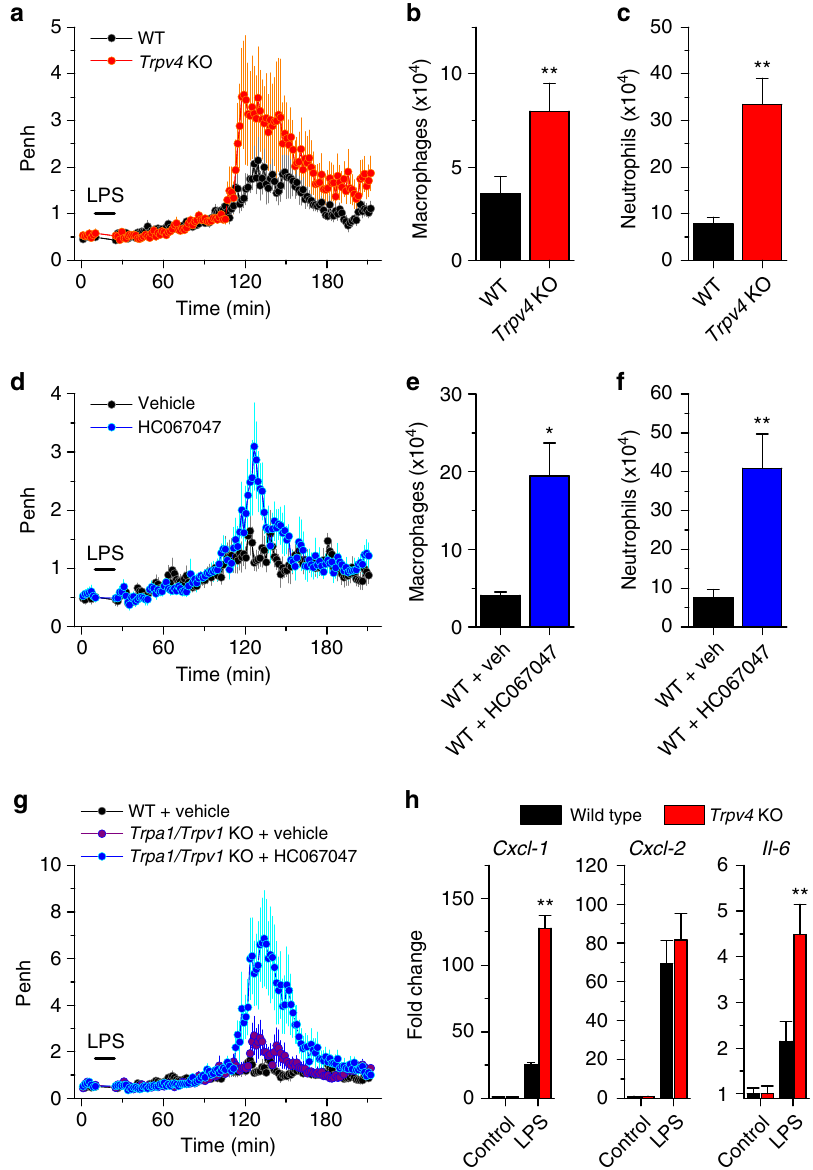
Fig. 7 TRPV4-de fi cient mice display exacerbated airway responses to LPS. a Time course of average enhanced pause (Penh) determined in unrestrained whole-body plethysmography experiments performed in wild type (WT, n = 10) and Trpv4 KO ( n = 7) mice exposed to aerosols of LPS. The area under the curve (AUC) of Trpv4 KO traces is signi fi cantly larger than AUC from WT (144 ± 56 > 47 ± 14; P = 0.048, unpaired t -test). b , c Average number of macrophages ( b ) and neutrophils ( c ) in the bronchoalveolar lavage fl uid collected 3 h after LPS exposure. ** P < 0.01, two-tailed t -test. d Average Penh determined in unrestrained whole-body plethysmography experiments performed in WT mice pretreated with vehicle (0.8% DMSO, n = 7) or the TRPV4 inhibitor HC067047 (10 mg kg − 1 in 0.8% DMSO, n = 8). The vehicle or HC067047 were administered intraperitoneally 15 min previous to the LPS challenge. AUC Vehicle = 23 ± 4 < AUC HC067047 = 54 ± 14; P = 0.039, unpaired t -test. e , f Average number of macrophages ( e ) and neutrophils ( f ) in